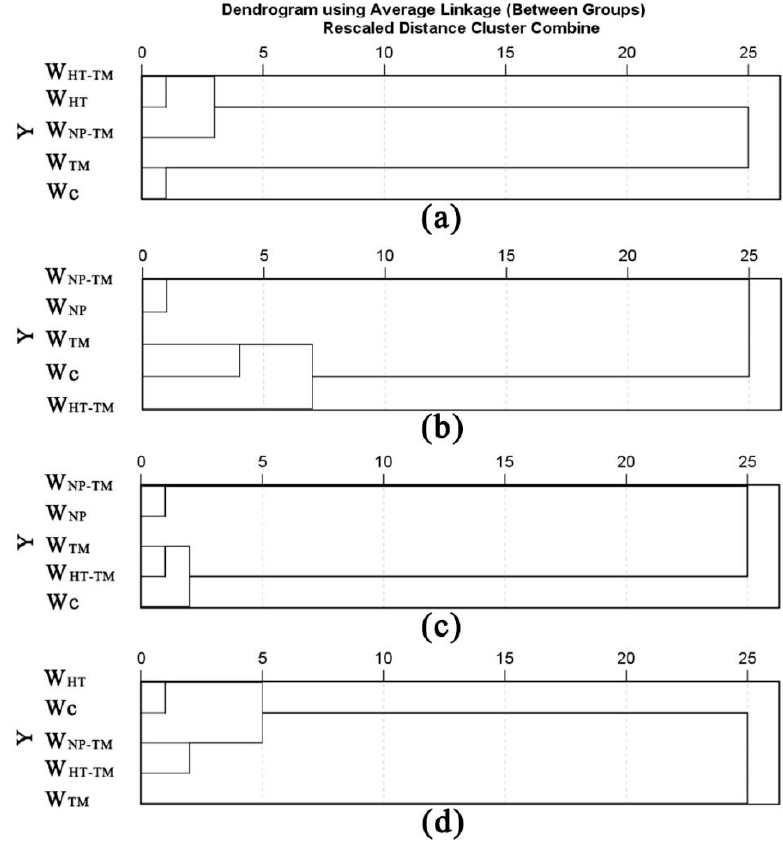
Figure 5. Hierarchical cluster analysis (HCA) of surface color ( a ), heat release ( b ), flue gas release ( c ), and compression recovery ( d ) based on different variables. Note: The horizontal axis shows the distances of clusters and the vertical axis shows combine treatment and the control group.